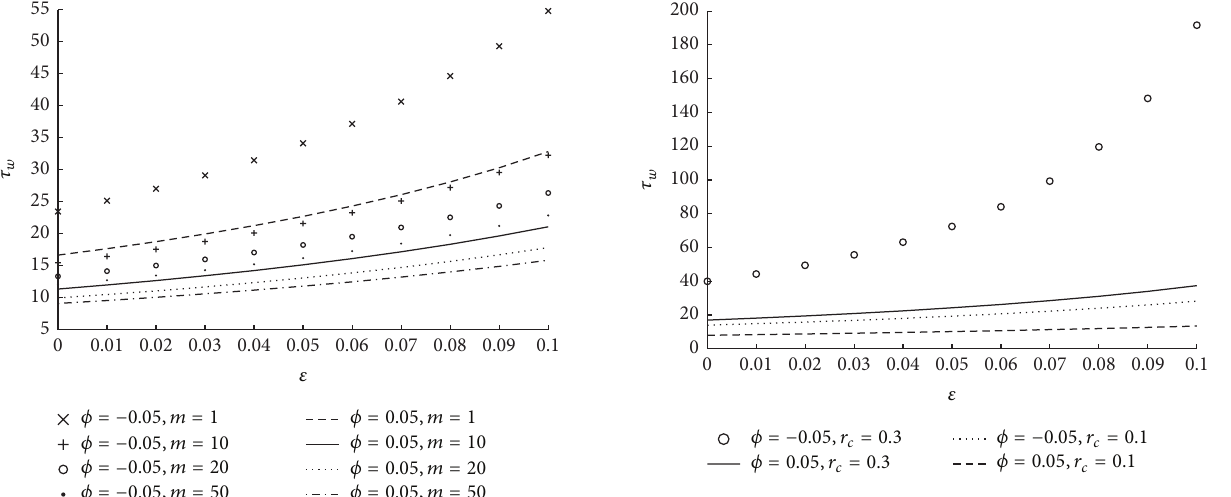
Figure 12: The variation of shear stress at wall with respect to 𝜙,𝑟 𝑐 at 𝑧 𝑅 when 𝑚 = 50 , 𝑁 = 0.75 , and 𝑢 = 0.01 .